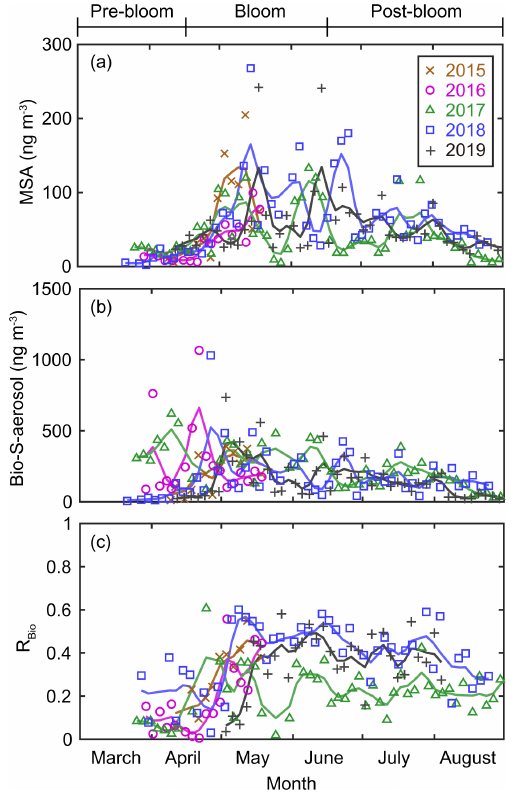
Figure 5. Aerosol concentrations of (a) MSA and (b) Bio-S-aerosol (MSA + Bio-SO 2 − ). (c) Variations in the ratio of MSA to Bio-S- 4 aerosol ( R Bio ). The colored solid lines indicate 15d moving mean